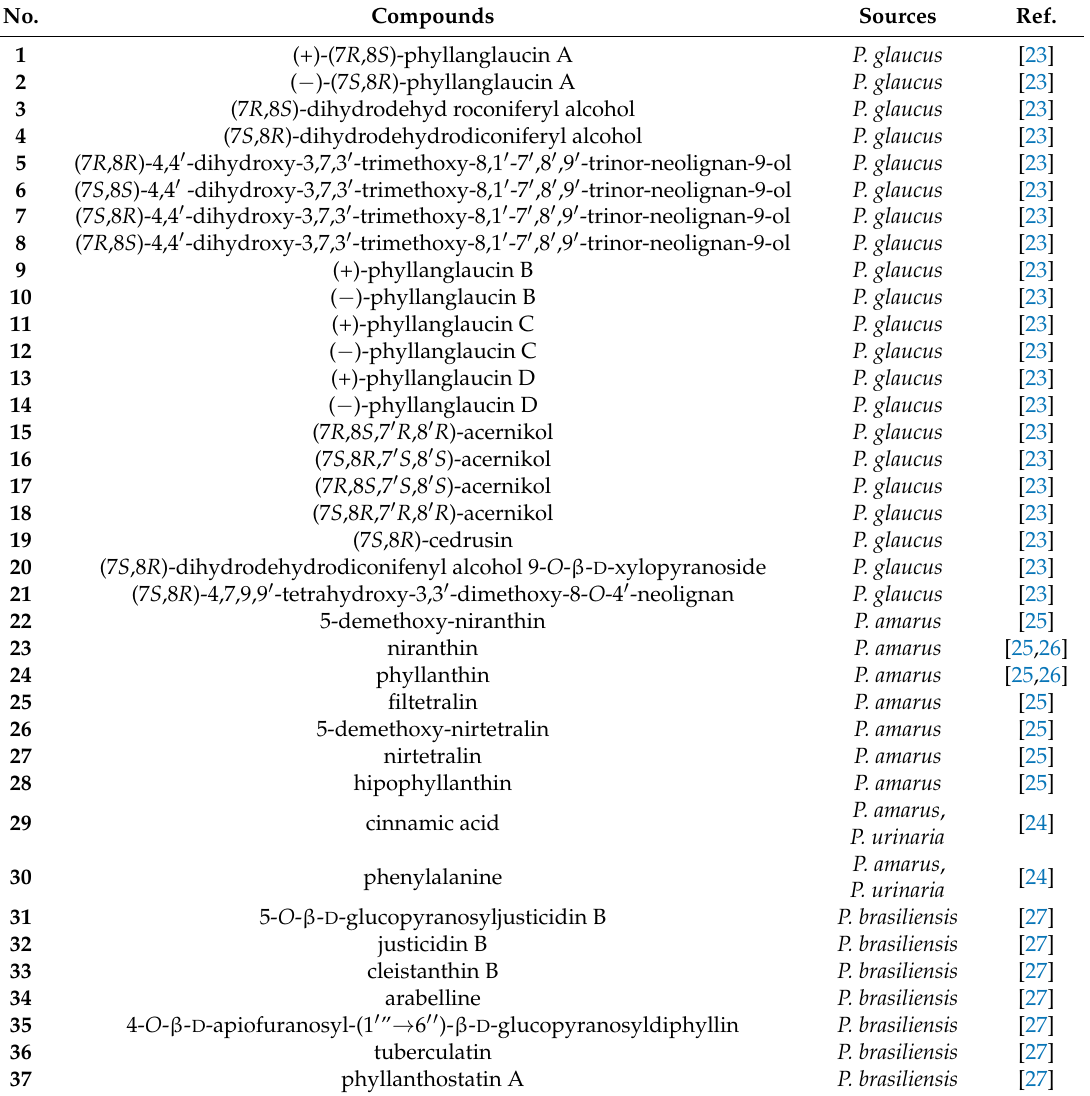
Table 1. Structures and sources of phenylpropanoids from different Phyllanthus